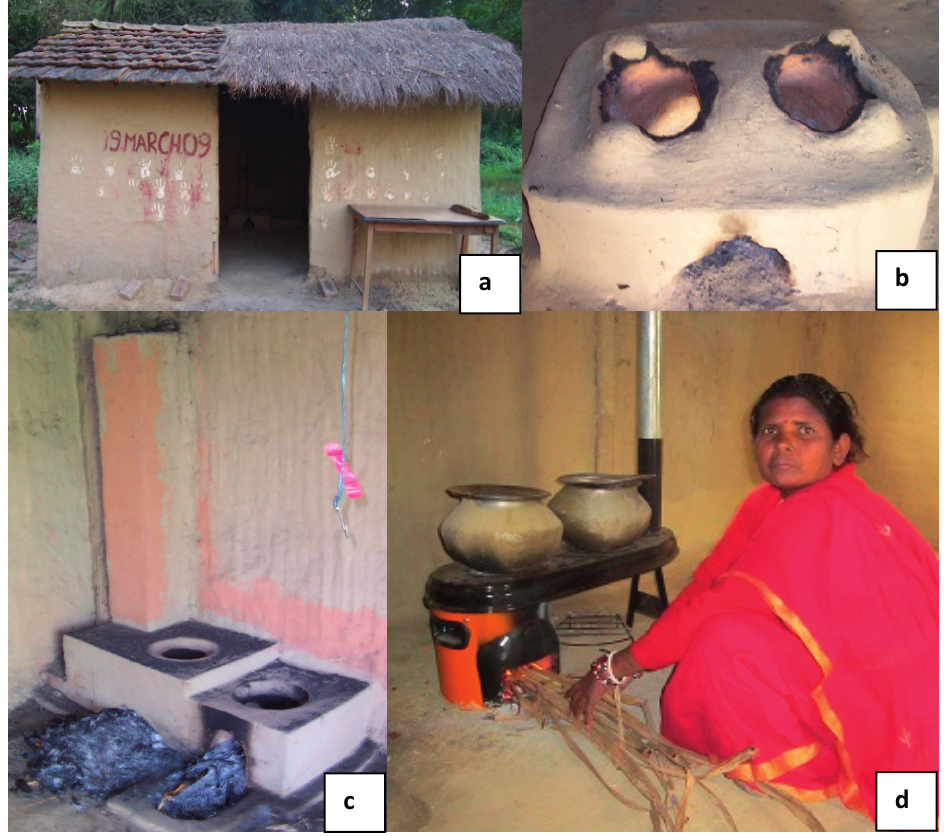
Figure 1. Study I photos of testing house and stoves used in water boiling test study in rural Nepal. ( a ) Single room test house, ( b ) traditional stove, ( c ) alternative mud-brick stove (AMBS-1), and (d) Envirofit G-series